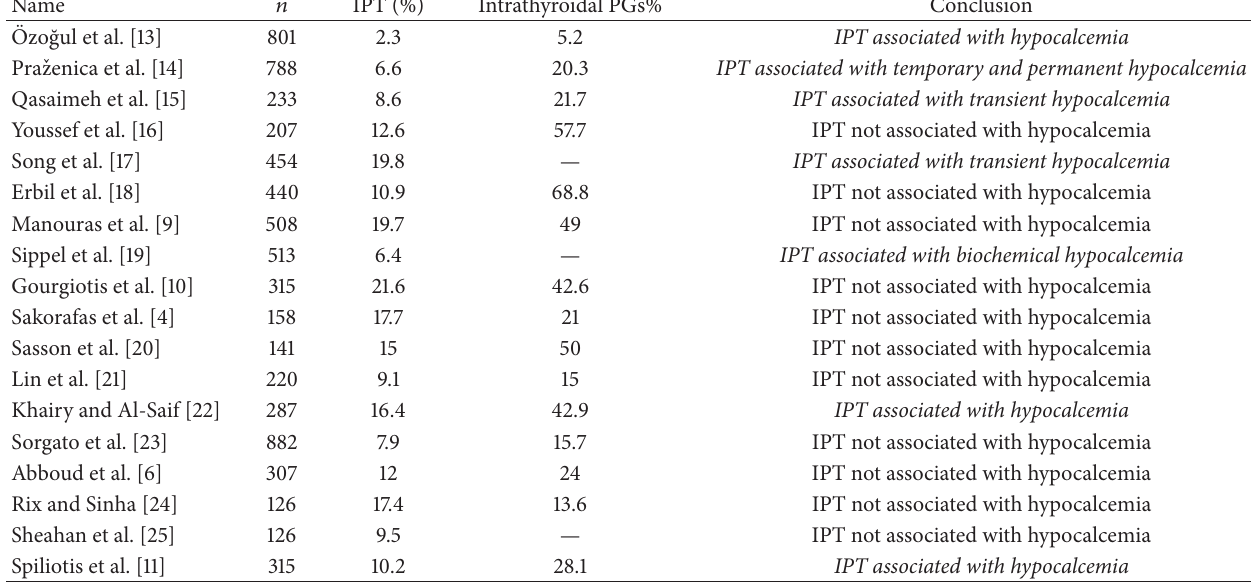
Table 5: Previous studies on incidental parathyroidectomy